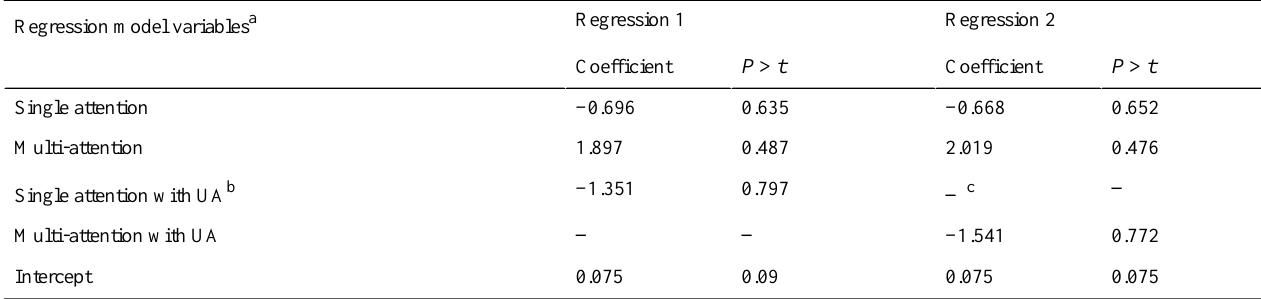
Table 3. Regression analysis results for assessing an association between attention values and effect